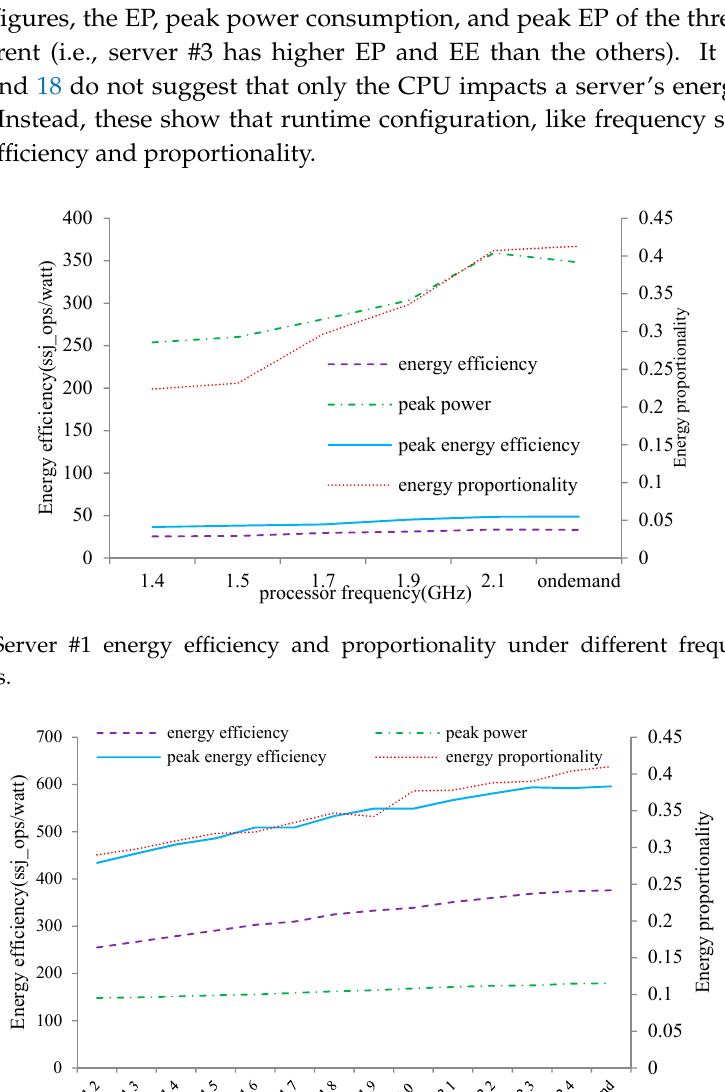
Table 10. Power consumption and performance comparison of heterogeneous cluster.